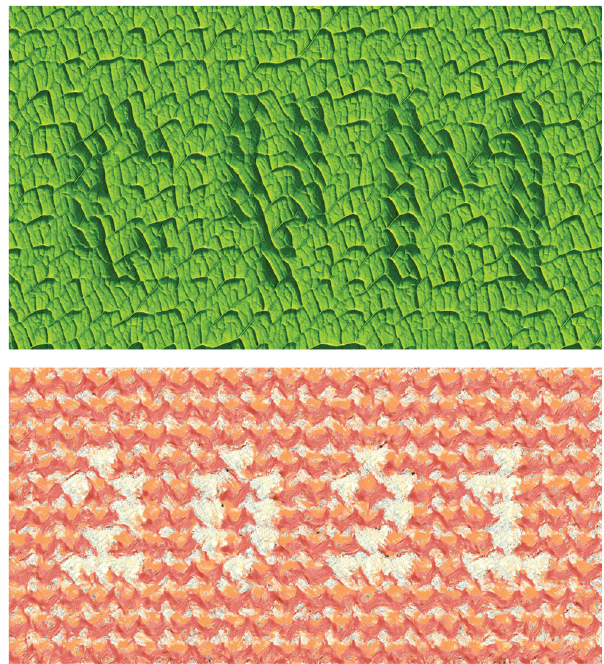
Fig. 16 Generating large textures with control. We can control the local appearance of the texture, by constructing the co-occurrence condition to the generator network. For these examples, we used co-occurrences from only two 128 × 128 crops of the original